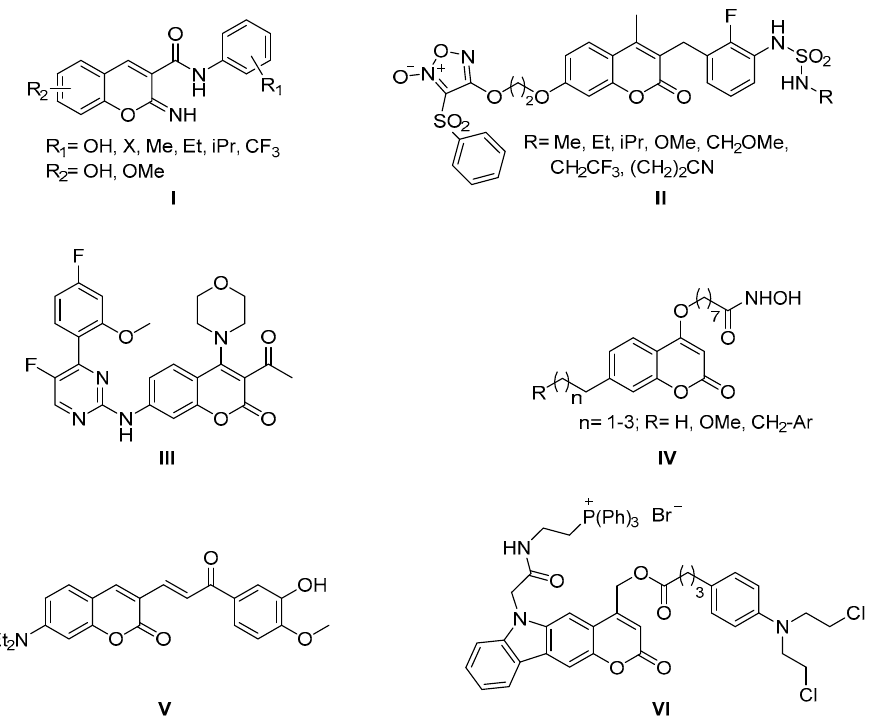
Figure 2. Structures of coumarin derivatives as anticancer agents.